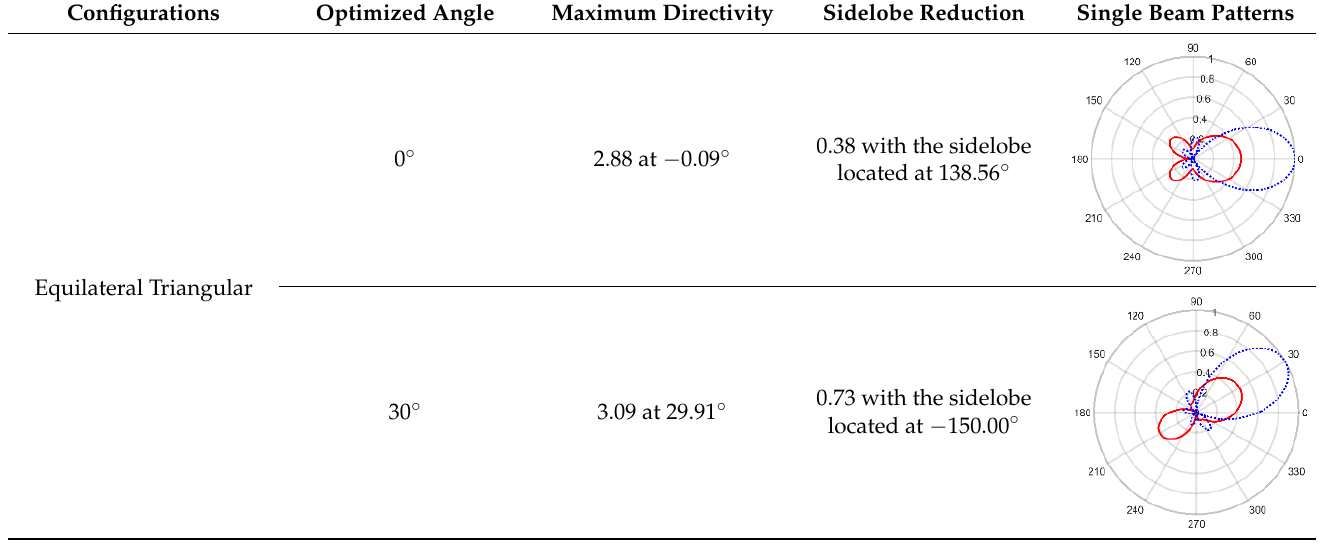
Table 1. Directivity, Sidelobe Reduction and Single Beam Patterns for the Array Models proposed in [14], where the blue and read lines are showing the desired beam and optimized beam patterns, respectively.